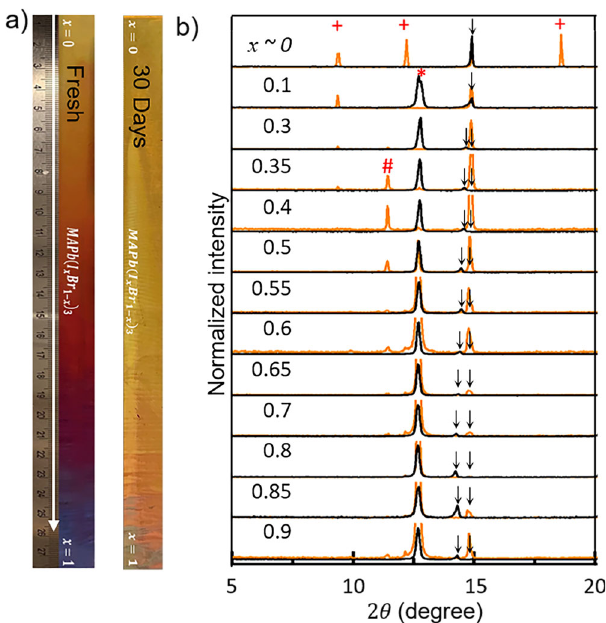
Fig. 3 Stability of MAPb(I x Br 1-x ) 3 CGFs. a Photographs of fresh and aged CGF fi lm. b mXRD spectra of fresh (black) and aged (orange) CGFs. The Bragg peaks assigned to perovskite ( ↓ ), PbI 2 (*), MA 4 PbI 6 *2H 2 O (#), and MAPbBr 3 and PbBr 2 hydrates ( + ) are